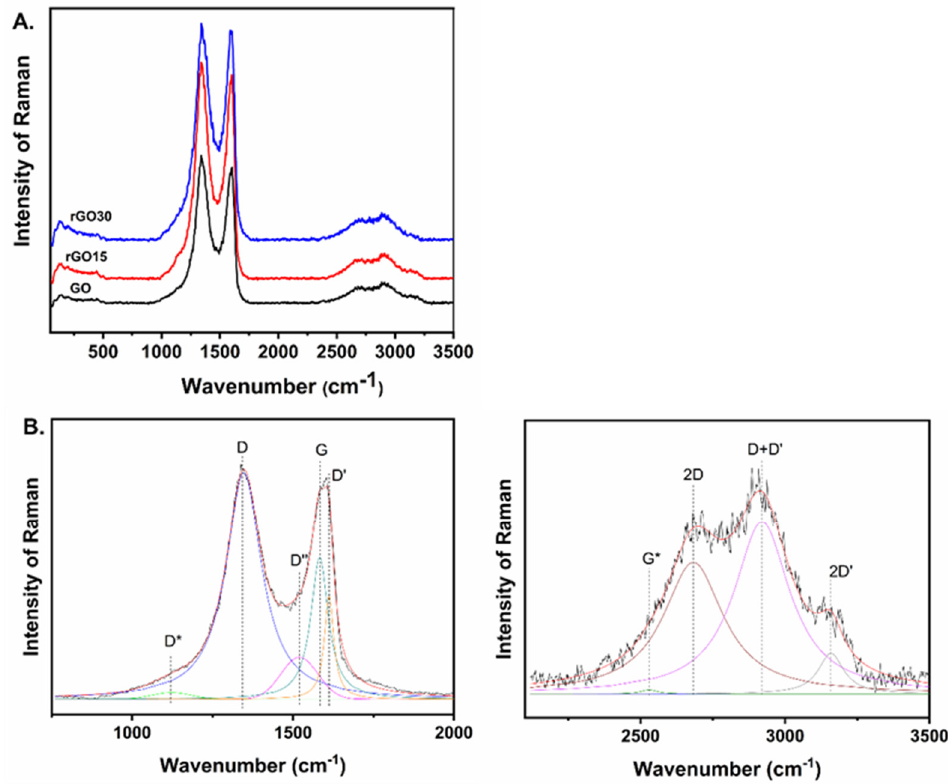
Figure 2. ( A ) Raman spectra of GO and reduced GO (rGO15 and rGO30). ( B ) Deconvolution of the Raman spectrum of GO.